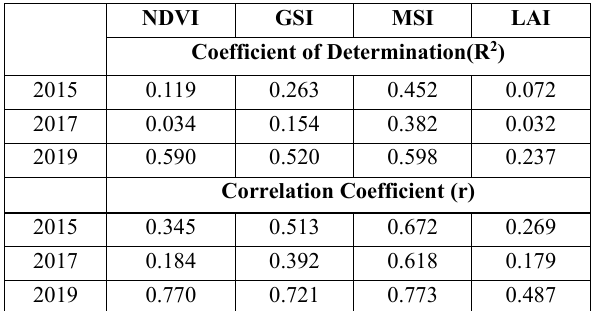
Figure 4: Scatter Plots for MSI Relationship in Landsat 8 OLI and Sentinel 2A